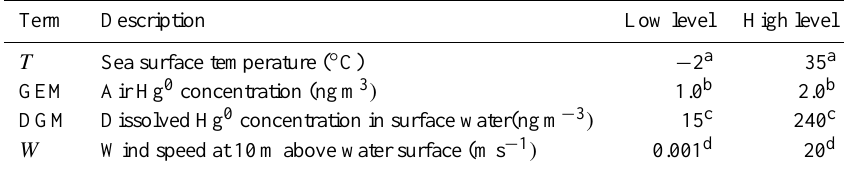
Table 2. Examined model variables and the experimental levels of factorial design for air–water exchange. Term Description Low level High level T Sea surface temperature ( ◦ C) − 2 a 35 a GEM Air Hg 0 concentration (ngm 3 ) 1.0 b 2.0 b DGM Dissolved Hg 0 concentration in surface water(ngm − 3 ) 15 c 240 c W Wind speed at 10m above water surface (ms − 1 ) 0.001 d 20